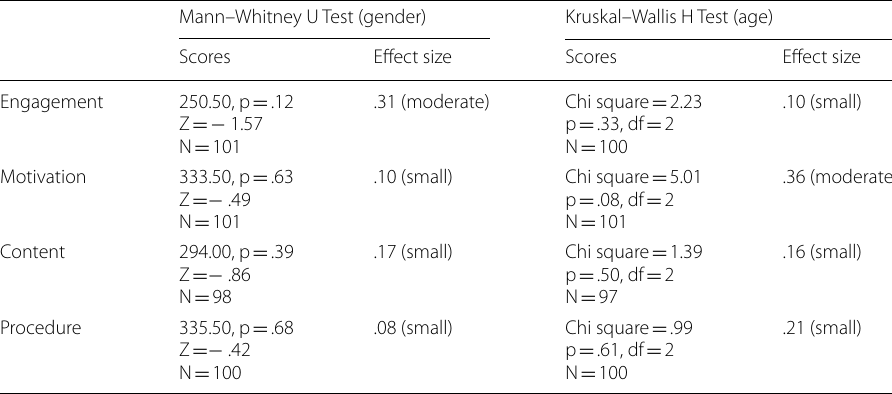
Table 2 Effect sizes for Mann–Whitney U Test and Kruskal–Wallis H Test